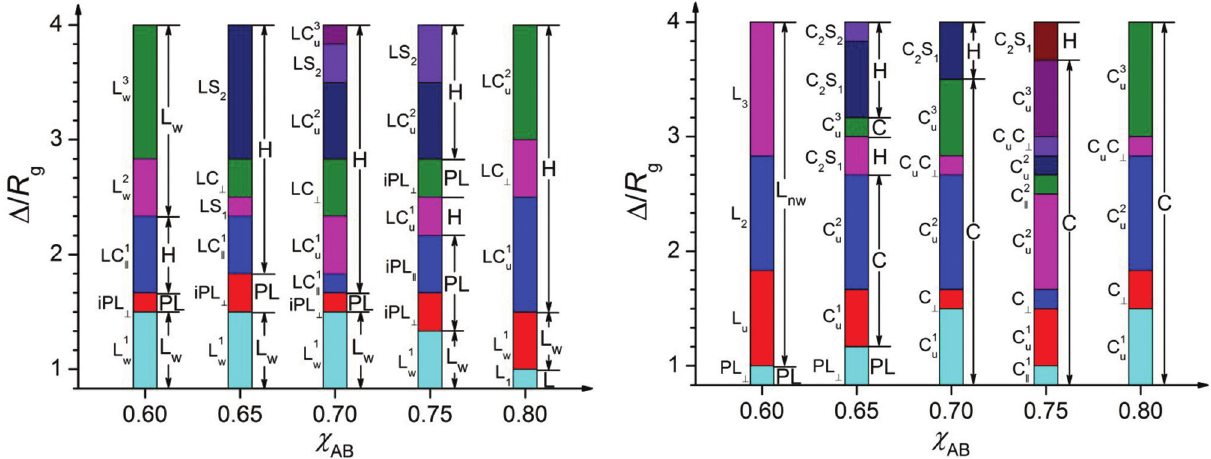
Figure 10: Phase diagram under weak attractive substrate (Λ = 0.6). Figure 11: Phase diagram under weak repellent substrate (Λ =